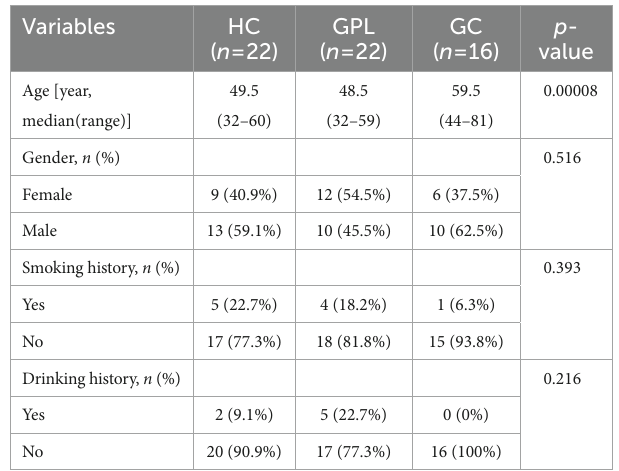
TABLE 1 Characteristics of study